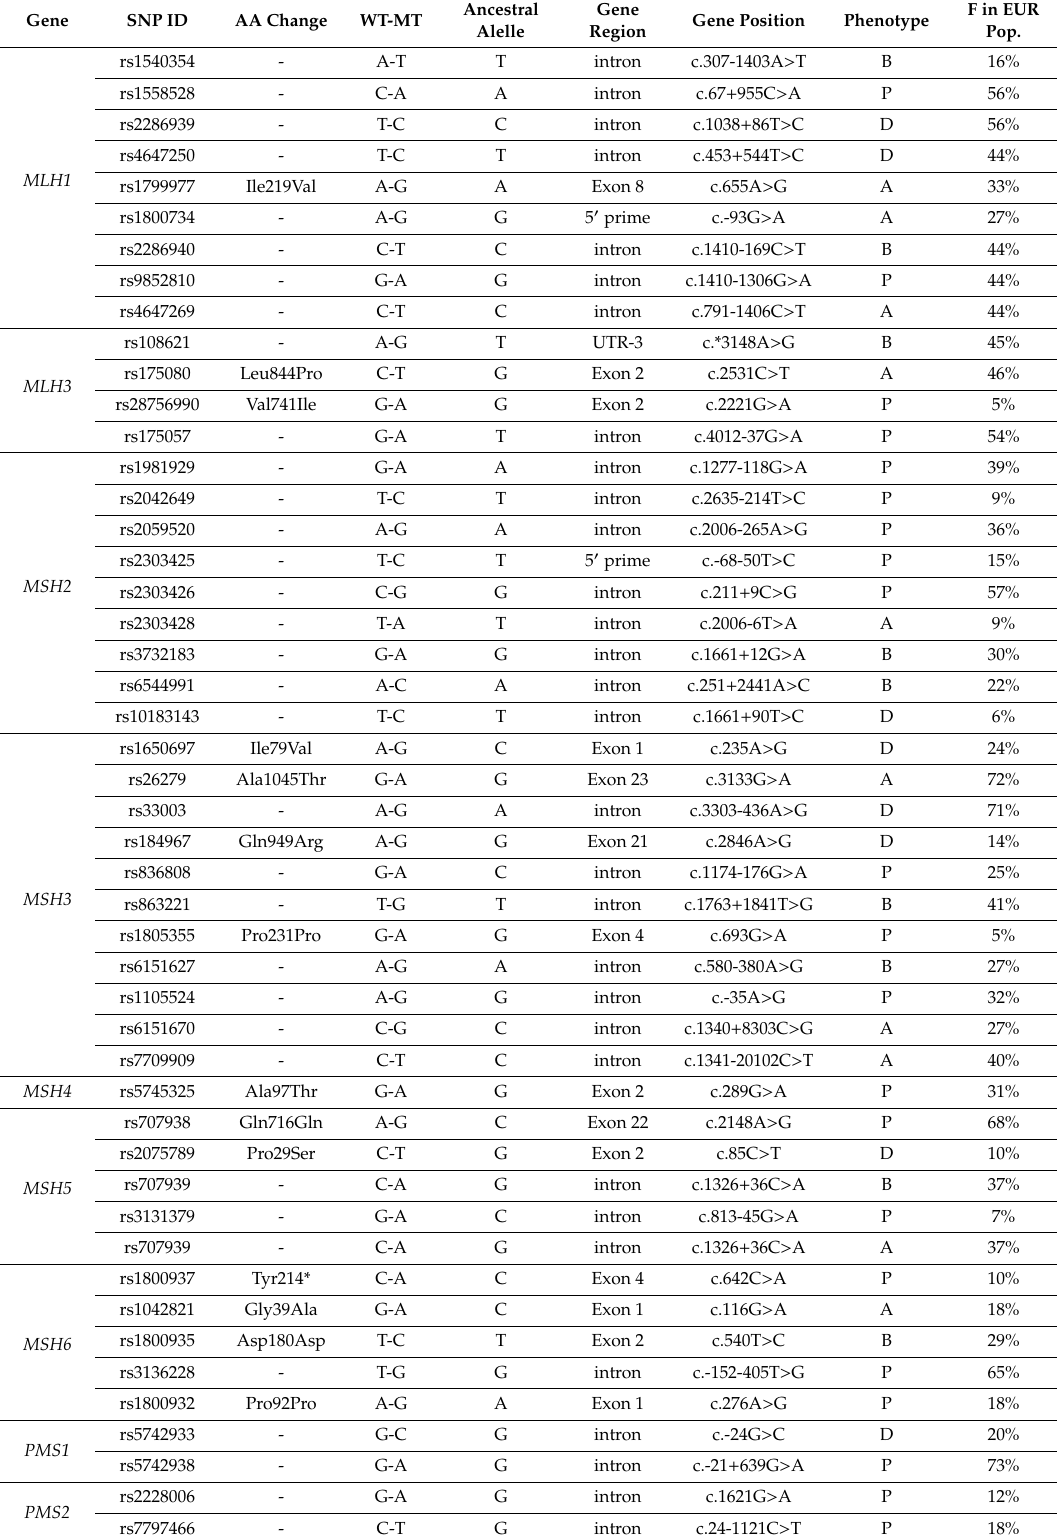
Table 2. The overview of SNPs in EUR population (F ≥ 5%) with known phenotype in the tumour development: B: benign, D: deleterious, A: ambiguous, P: